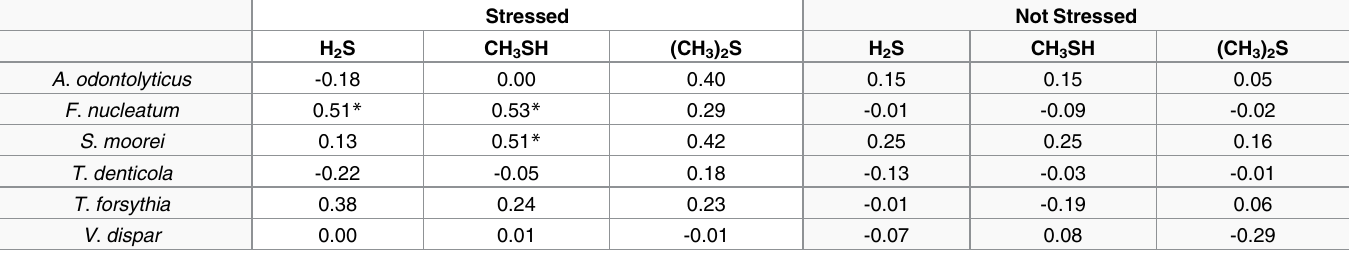
Table 2. Correlation coefficients (rS) between H 2 S, CH 3 SH, and (CH 3 ) 2 S and the relative proportions of A . odontolyticus , F . nucleatum , S . moorei , T . denticola , T . forsythia , and V . dispar in the saliva of subjects from the “Stressed” and “Not stressed”